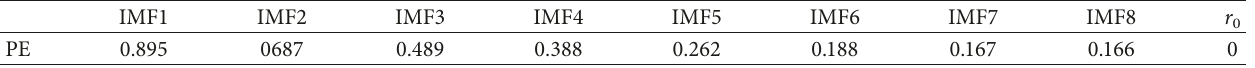
Table 3: PE values of the CEEMDAN decomposed IMFs.